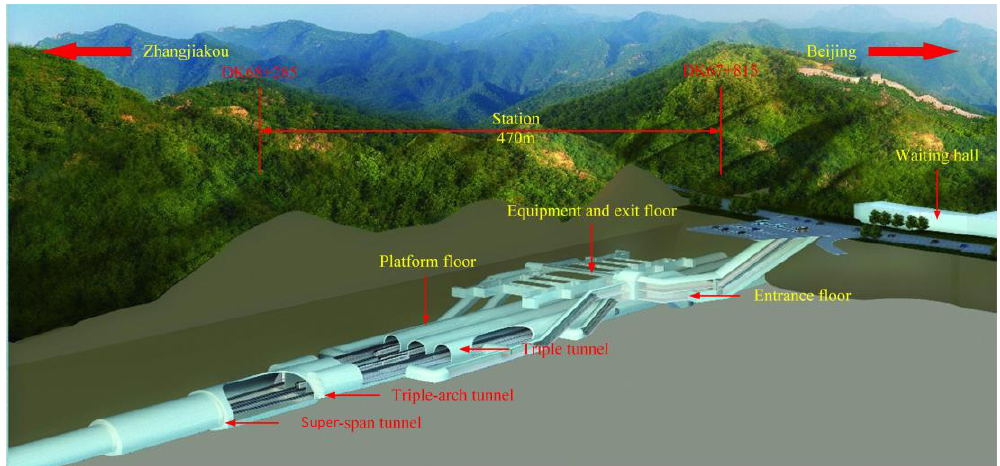
Figure 2. The main structure of the Badaling Great Wall station.